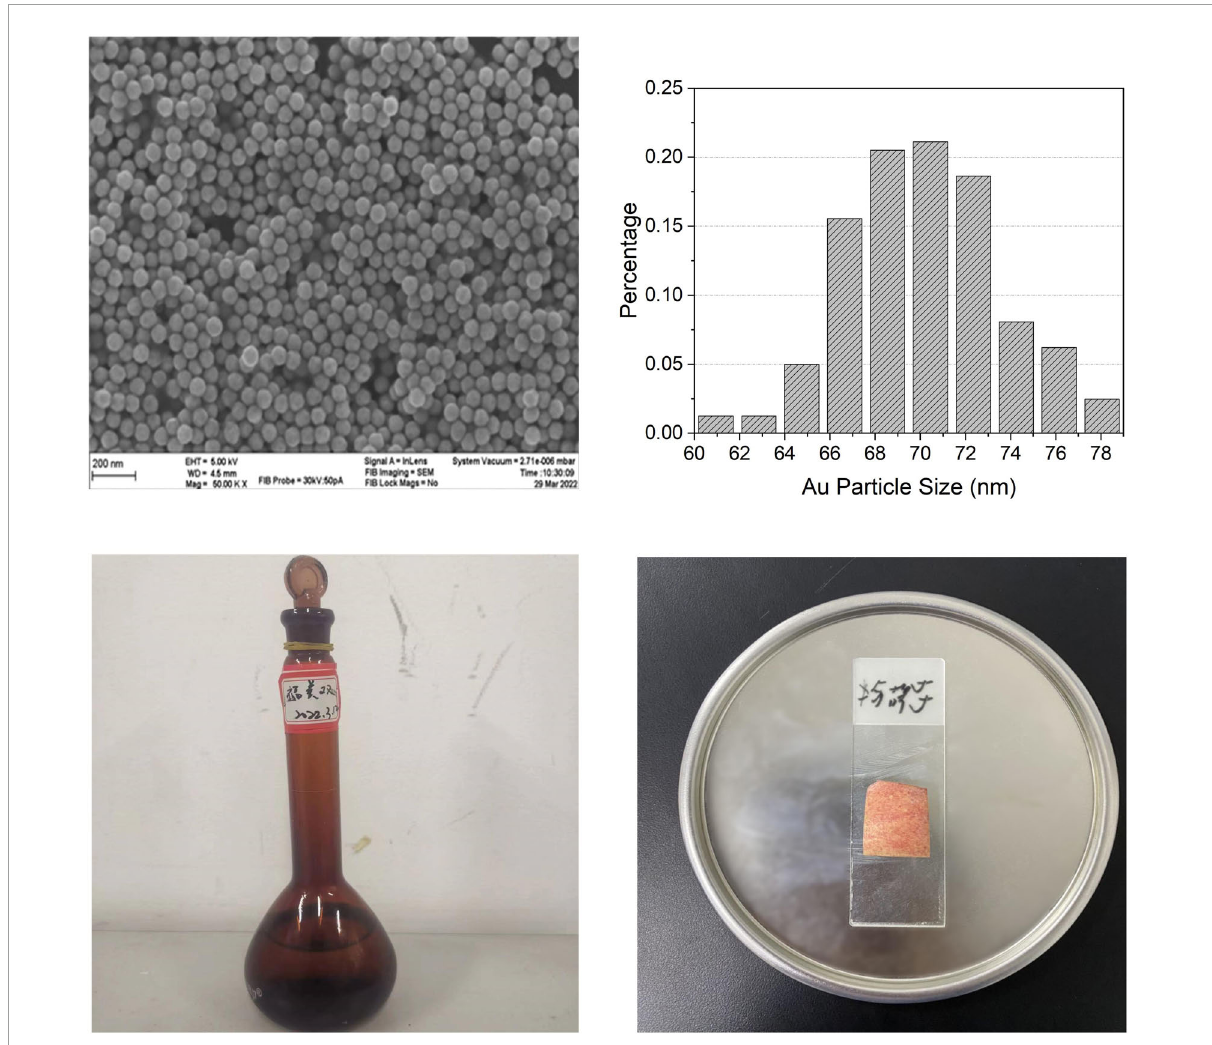
FIGURE2 (A) Scanning electron microscope diagram of Au-NPs. (B) Particle diameter distribution diagram. (C) Preparation of thiram solution. (D) Dropping Au-NPs solution on the surface of the